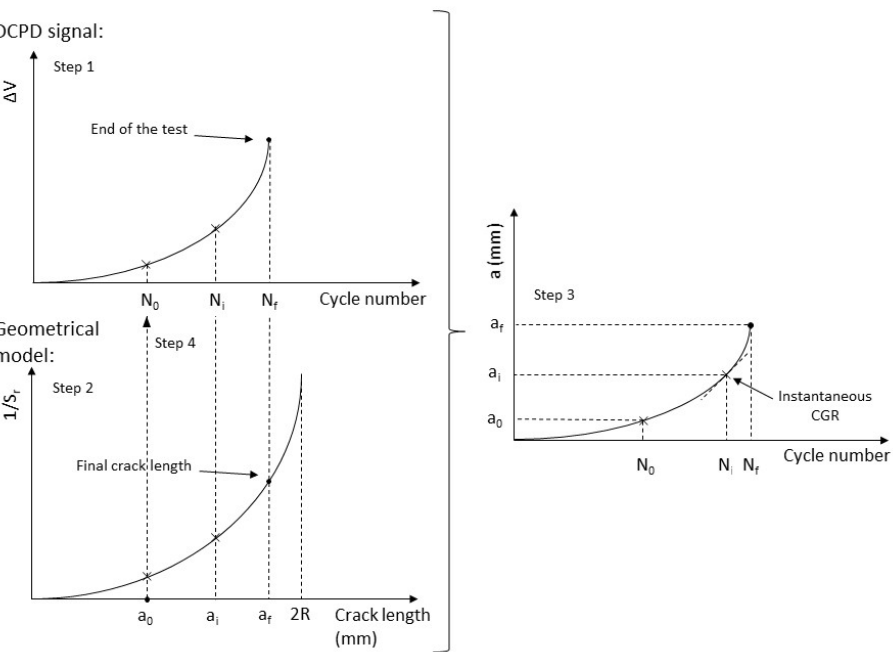
Figure 6. Estimation of the crack length when initiation is completed as function of the number of cycles (figure on the right) combining the DCPD signal ( top left ) and the applied geometrical model ( bottom left ).